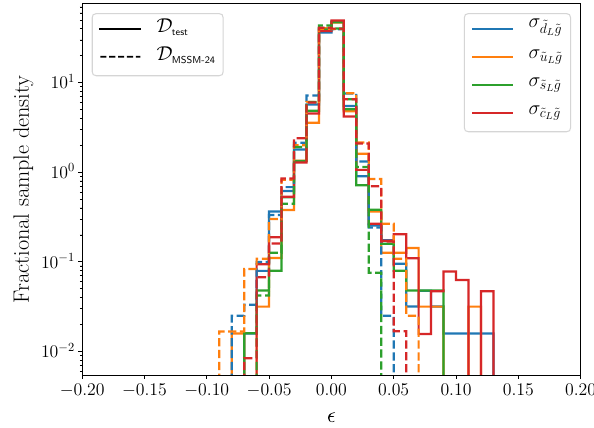
Fig. 11 The relative error (left) and residual (right) distributions for the first and second-generation gluino-squark cross-sections, for the test sets D test (solid) and D MSSM-24 (dashed). All distributions are nor-